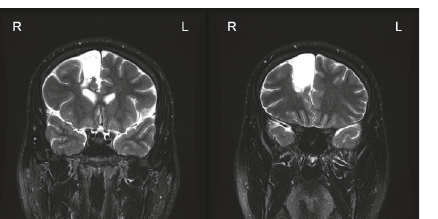
Figure 1: Transaxial multisequential magnetic resonance imaging of the brain in the form of a T1 weighted image (WI), T2 WI, and fluid-attenuated inversion recovery (FLAIR) WI, showing an extra- axial, well-defined elliptical lesion located in the right frontal region.